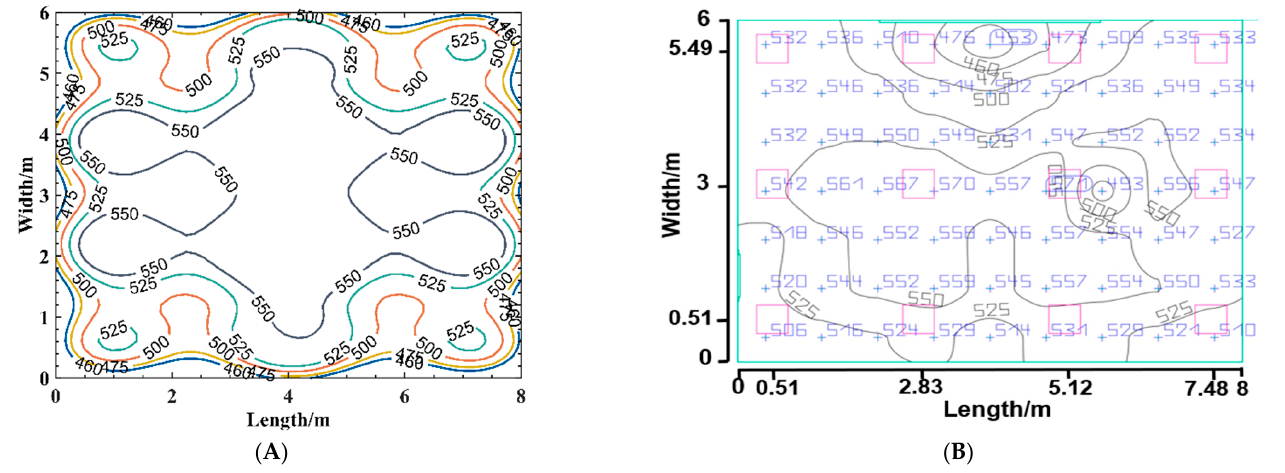
Figure 9. Contour map of illumination distribution on the working plane. ( A ) Results from the developed program and ( B ) results from DIALux.